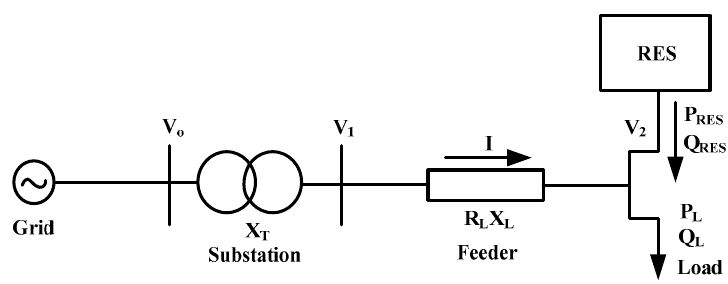
Figure 5. Grid connected system with RES and load.